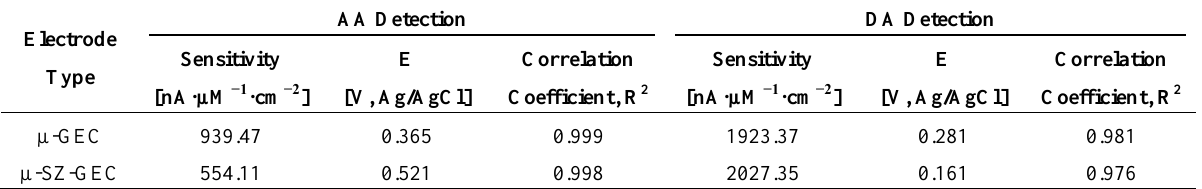
Table 3. Analytical parameters of the individual detection of DA (concentration range between 125 µM–1.5 mM) and AA (concentration range between 125 µM–1.5 mM) at quasi-microsensors using